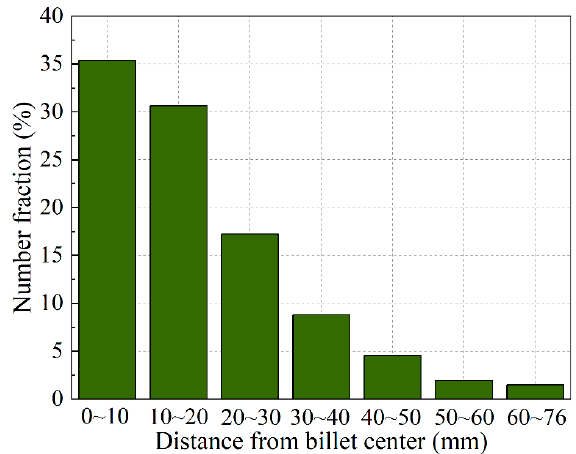
Figure 9. Number fraction of the grains that were entrapped at various distances from the billet center. To investigate the e ff ect of the grain size on the distribution of the floating grains in a DC-cast billet, another simulation was carried out with grains of di ff erent diameters, and the results are shown in Figures 10 and 11. The simulated distributions of the grains with di ff erent diameters at di ff erent calculation times are presented in Figure 10. At t = 0 s, the grains with di ff erent diameters are